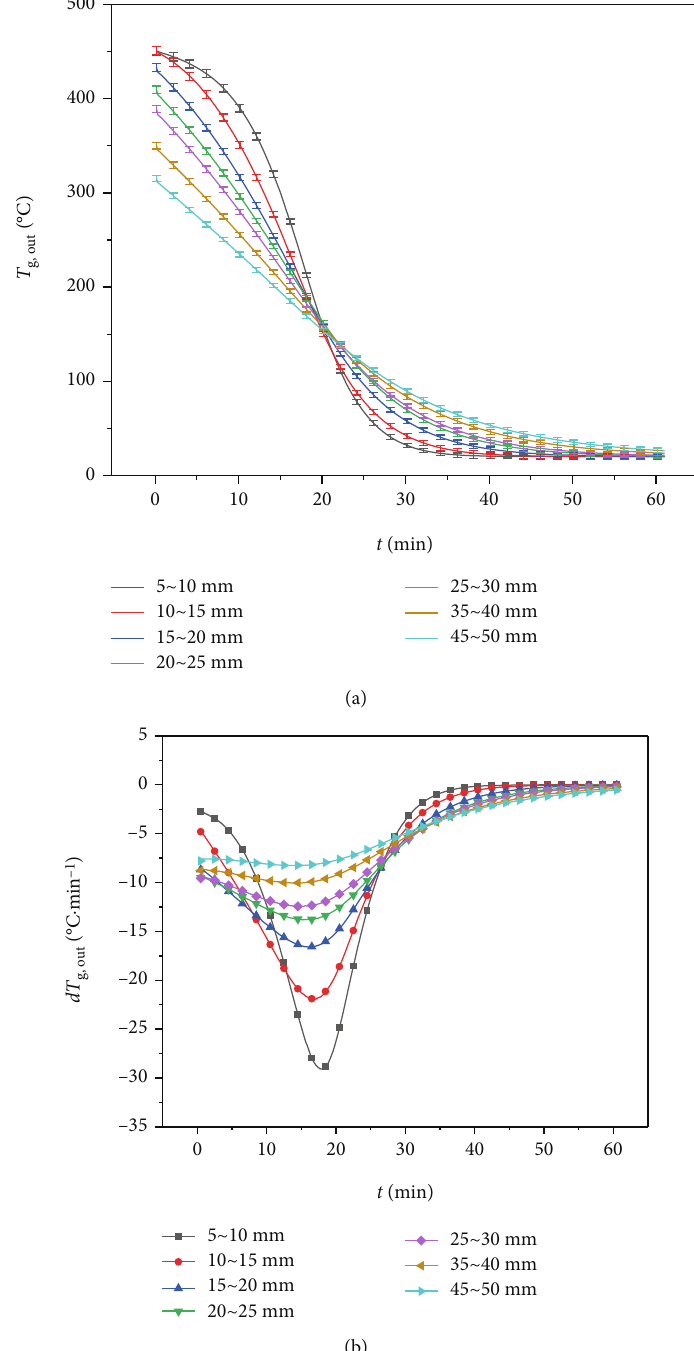
Figure 15: Variation of the gas outlet temperature T the gas velocity of 0.8m · s -1